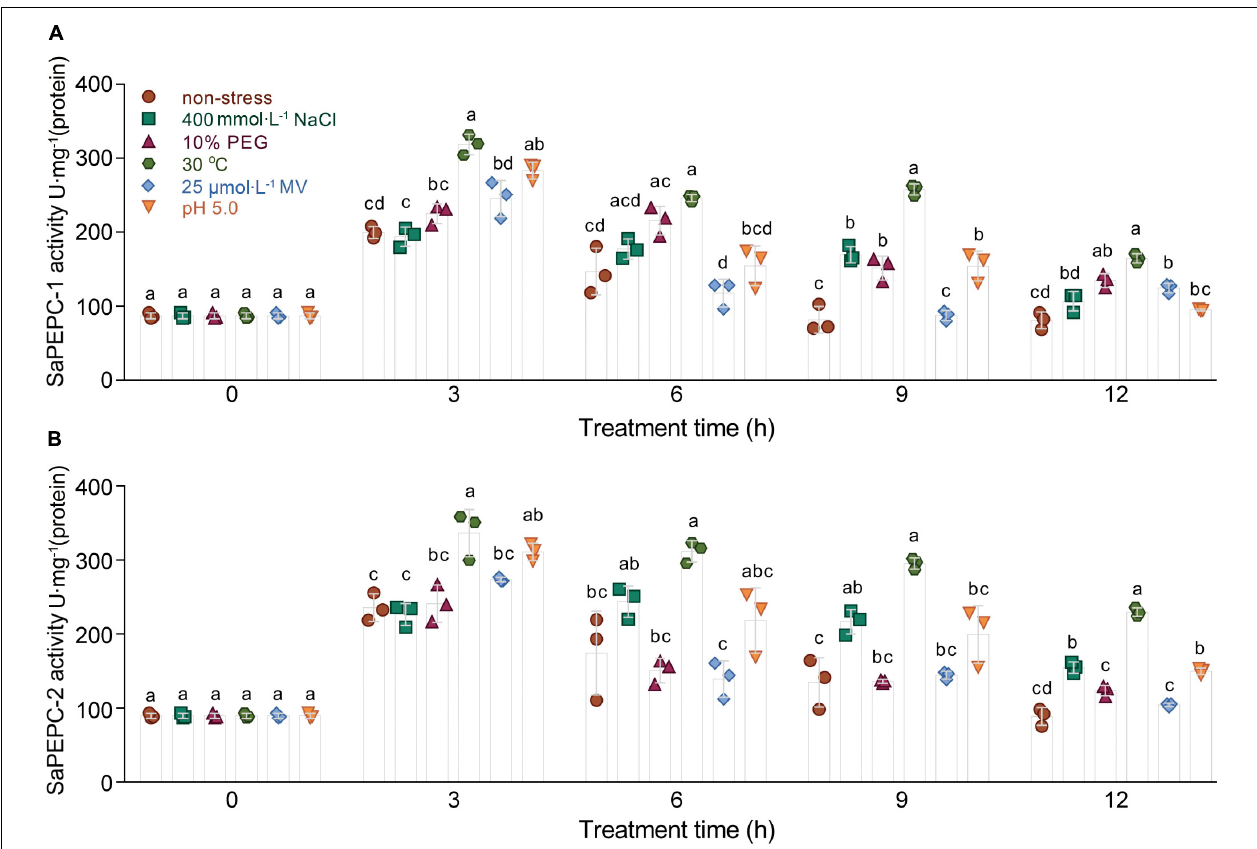
FIGURE 10 | Ectopic expression of two SaPEPC genes confers abiotic stress tolerance to Escherichia coli . (A,B) Activity analysis of recombinant SaPEPC-1 and SaPEPC-2 under abiotic stresses [400 mmol · L – 1 NaCl, 10% PEG, 25 µ mol · L – 1 methyl viologen (MV), 30 ◦ C and pH 5.0]. Different lowercase letters indicate significant difference among different stresses at the same time. Values are means ± SD of three